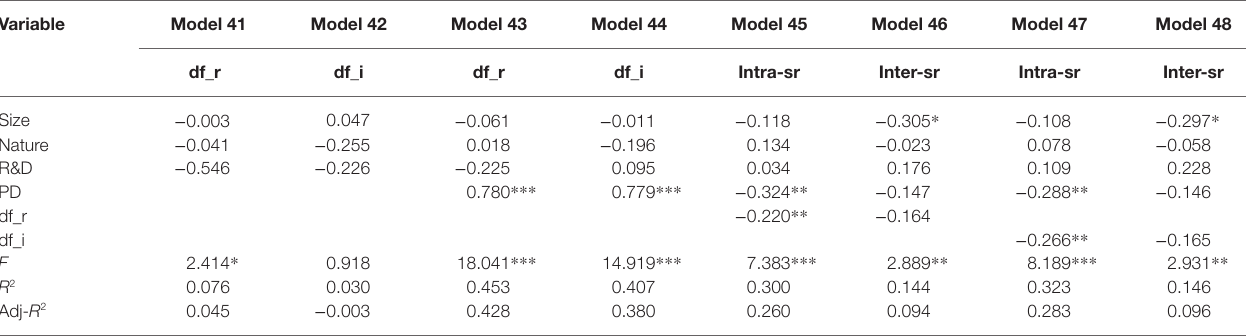
TABLE 9 | The mediation effects of divisive faultlines (Group 2; N =